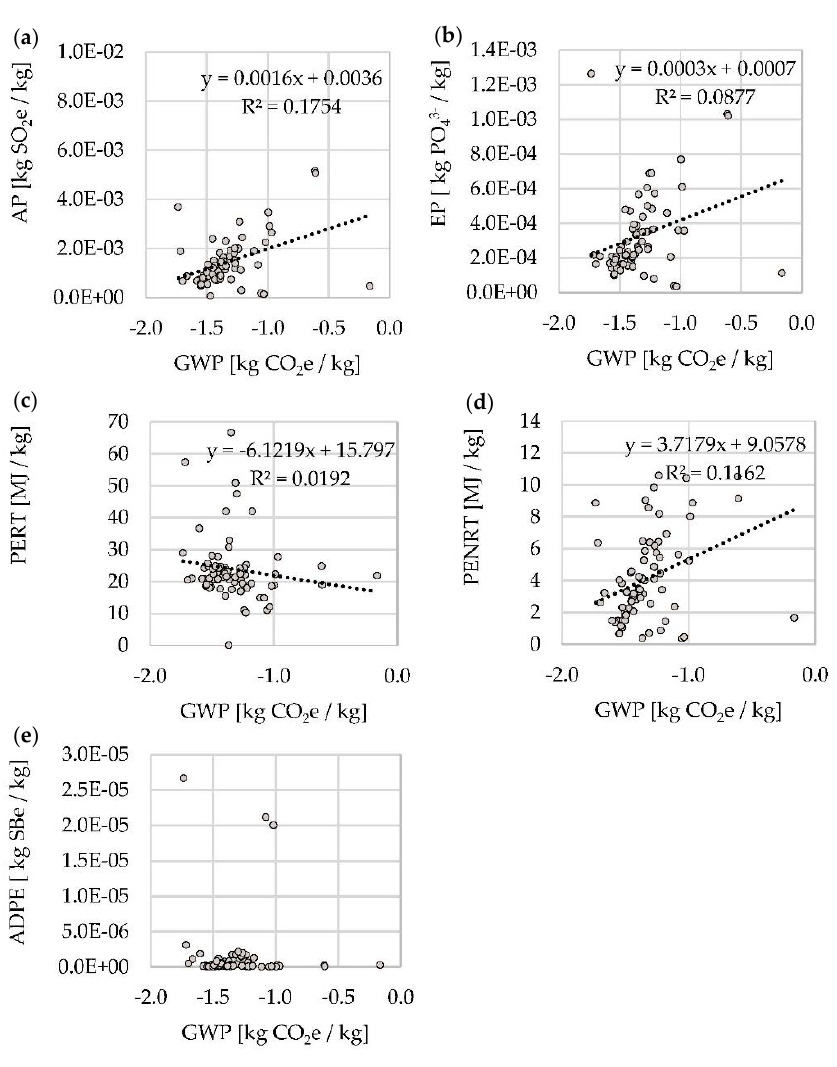
Figure 8. ( a ) Correlation between GWP and AP for life cycle modules A1 – A3. ( b ) Correlation between GWP and EP for life cycle modules A1 – A3. ( c ) Correlation between GWP and PERT for life cycle modules A1 – A3. ( d ). Correlation between GWP and PENRT for life cycle modules A1 – A3. ( e ) Correlation between GWP and ADPE for life cycle modules A1 – A3.